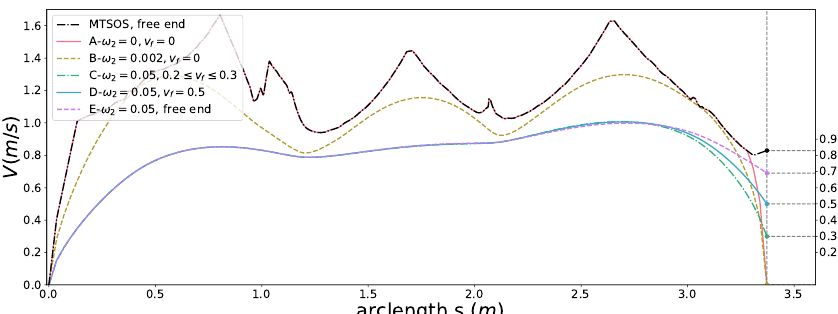
Figure 8. Speed planning results with different end boundary